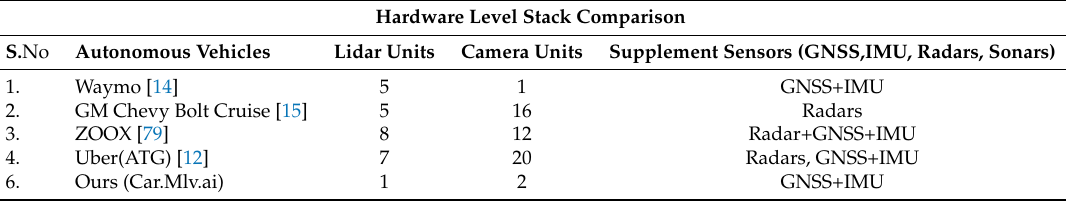
Table 7. Hardware level stack comparison between state-of-the-art and our autonomous vehicle in term sensor